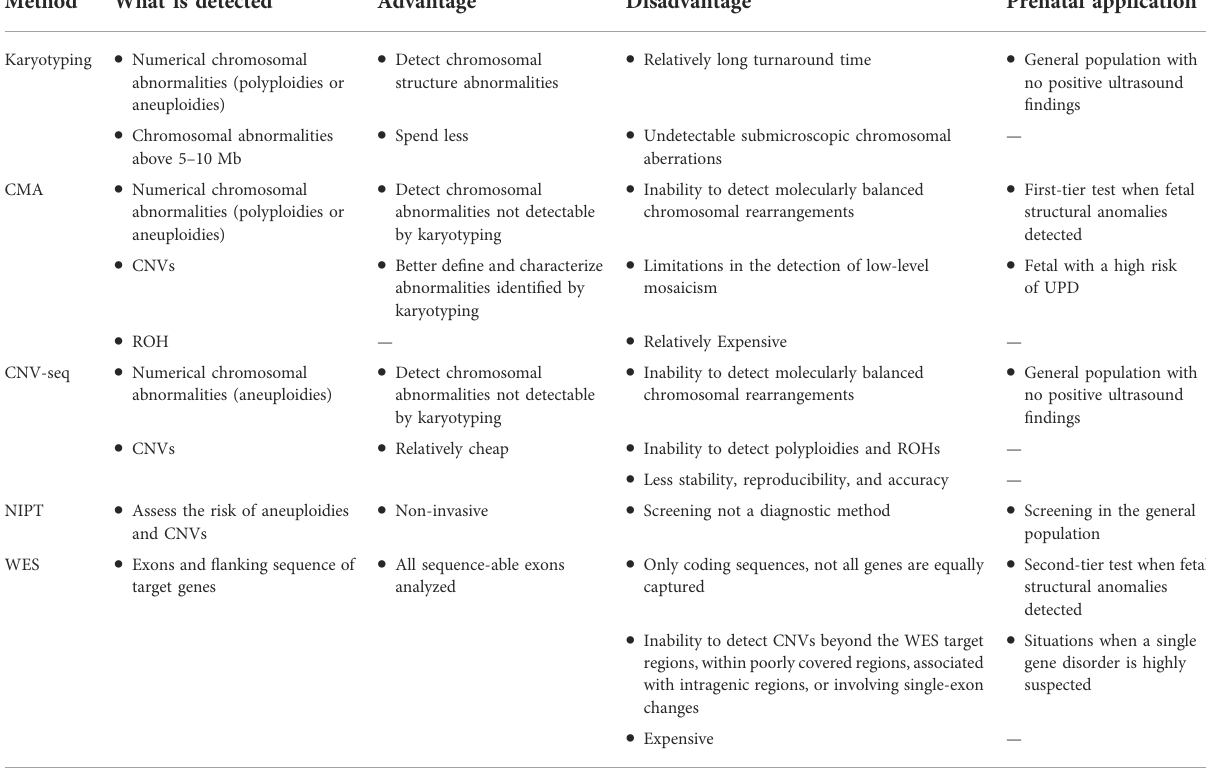
TABLE 1 Summary of prenatal diagnosis/screening methods. Method What is detected Advantage Disadvantage Prenatal application Karyotyping (cid:129) Numerical chromosomal abnormalities (polyploidies or